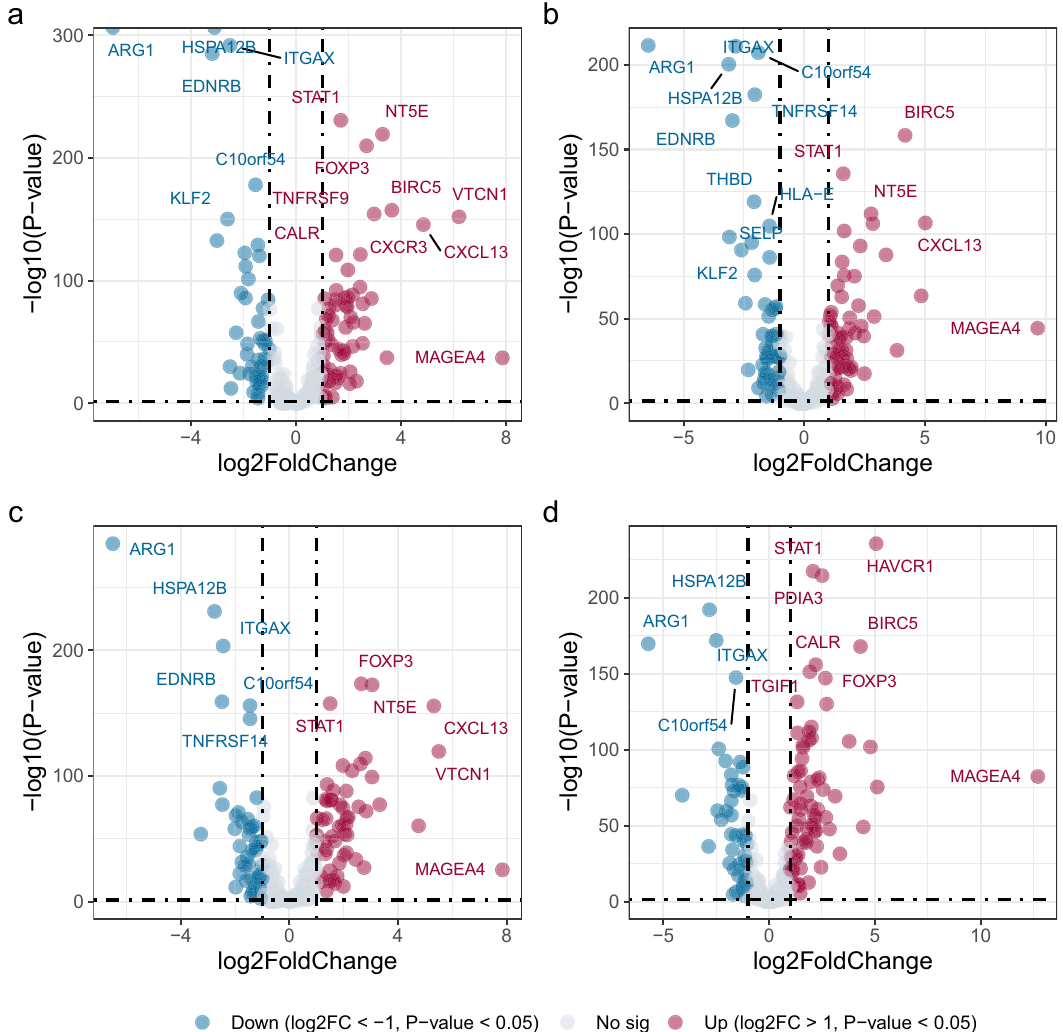
Fig. 3 A volcano plot of differential expression genes between four subtypes and GTEx samples. The red dots indicate upregulated genes, blue dots indicate downregulated genes and gray dots are not signi fi cantly genes. a Cluster 1. b Cluster 2. c Cluster 3. d Cluster